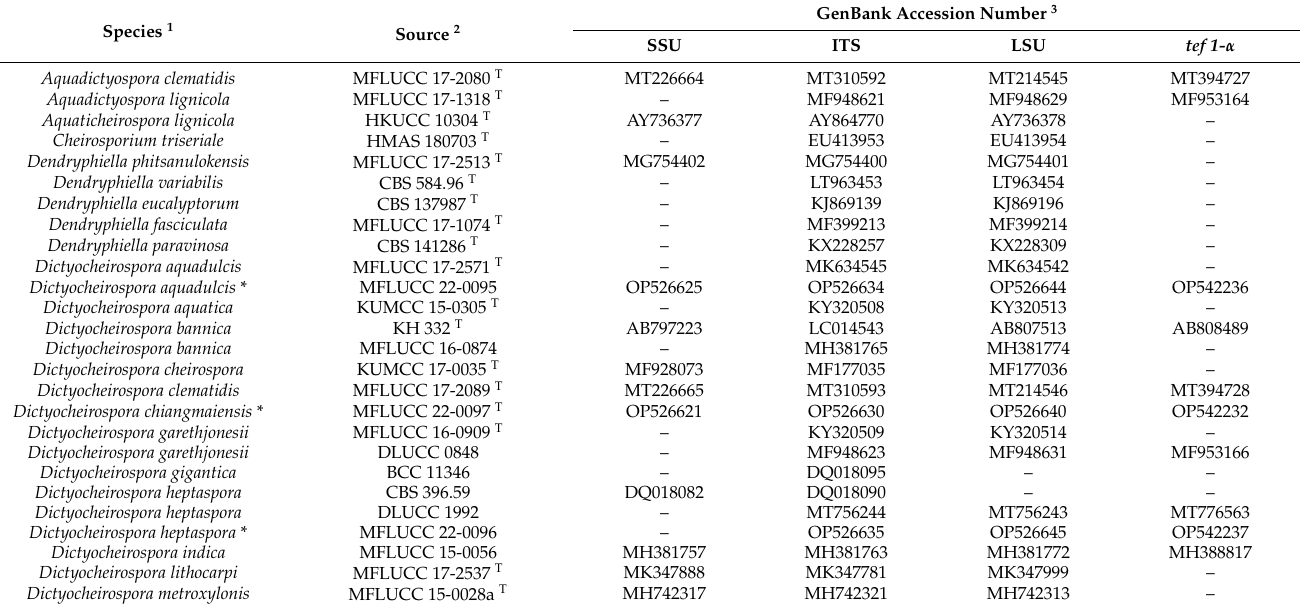
Table 1. Strains/specimens used for phylogenetic analysis and their GenBank accession